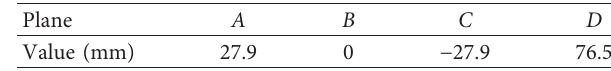
Figure 11: Schematic of monitoring points. Table 3: Plane coordinates of the X -axis.